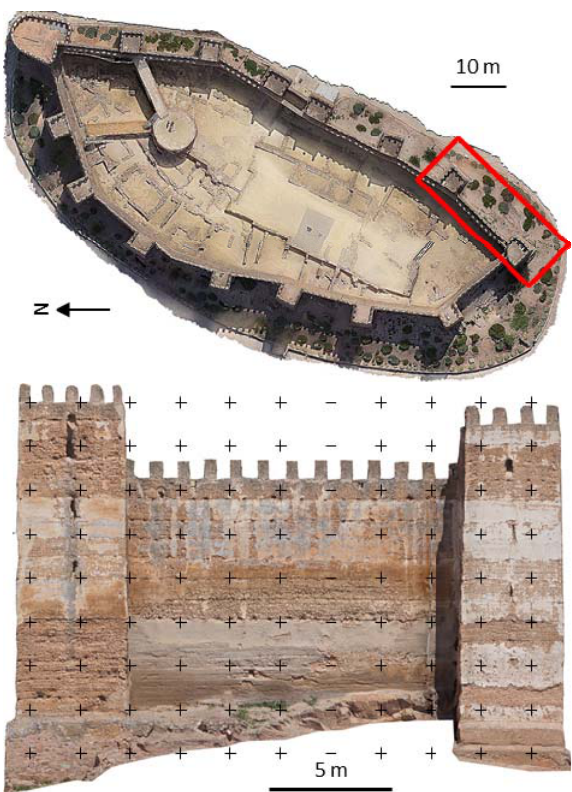
Figure 16.Upper: orthoimage, 2 cm resolution, of Burgalimar Castle. Lower: orthoimage, 2 cm resolution, of the SE towers and curtain wall (red box in upper ortho), the ortho is projected onto the plane parallel to the curtain